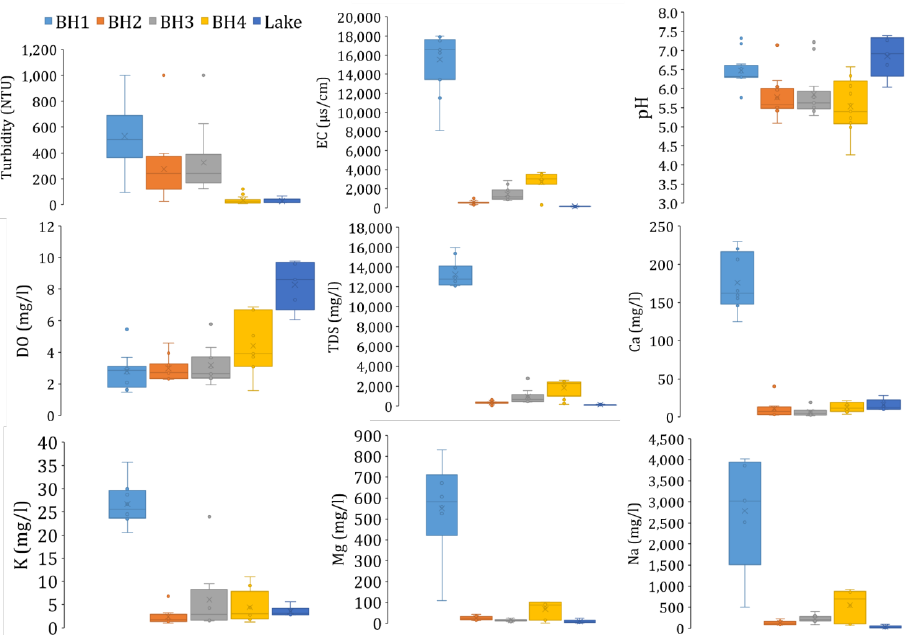
Figure 7. Boxplots of physico-chemical parameters (Turbidity, EC, pH, DO and TDS) and ion concentrations (Ca, Mg, Na, K). Boxes represent the central half of the data, with the bar in the middle as the median; start of bottom whisker and end of the top whisker represents the lowest and highest values that are not outliers; circles are outliers outside 10th and 90th percentiles.